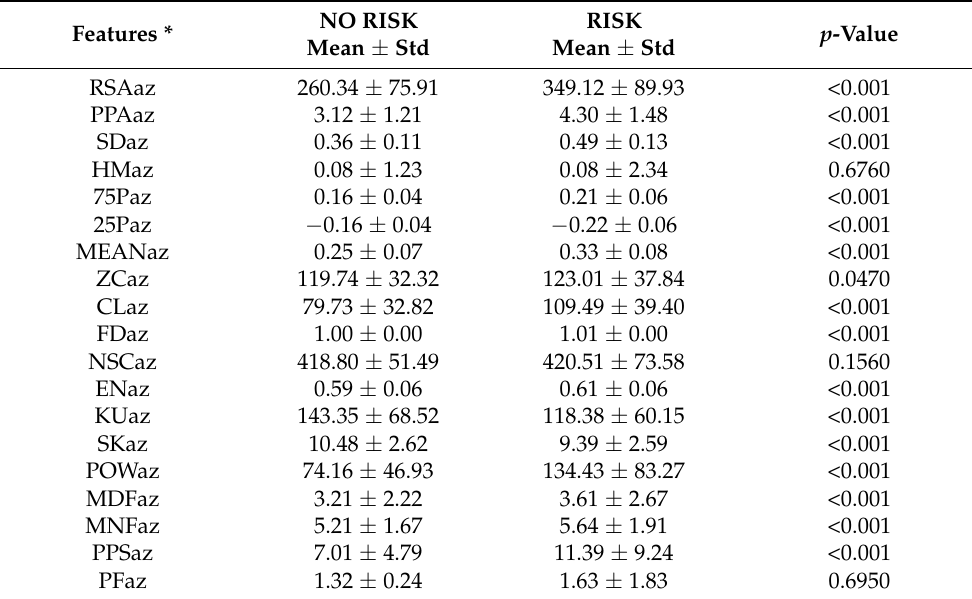
Table 6. Paired t -test NO RISK/RISK classes for each feature extracted from z -axis acceleration (az). Features *